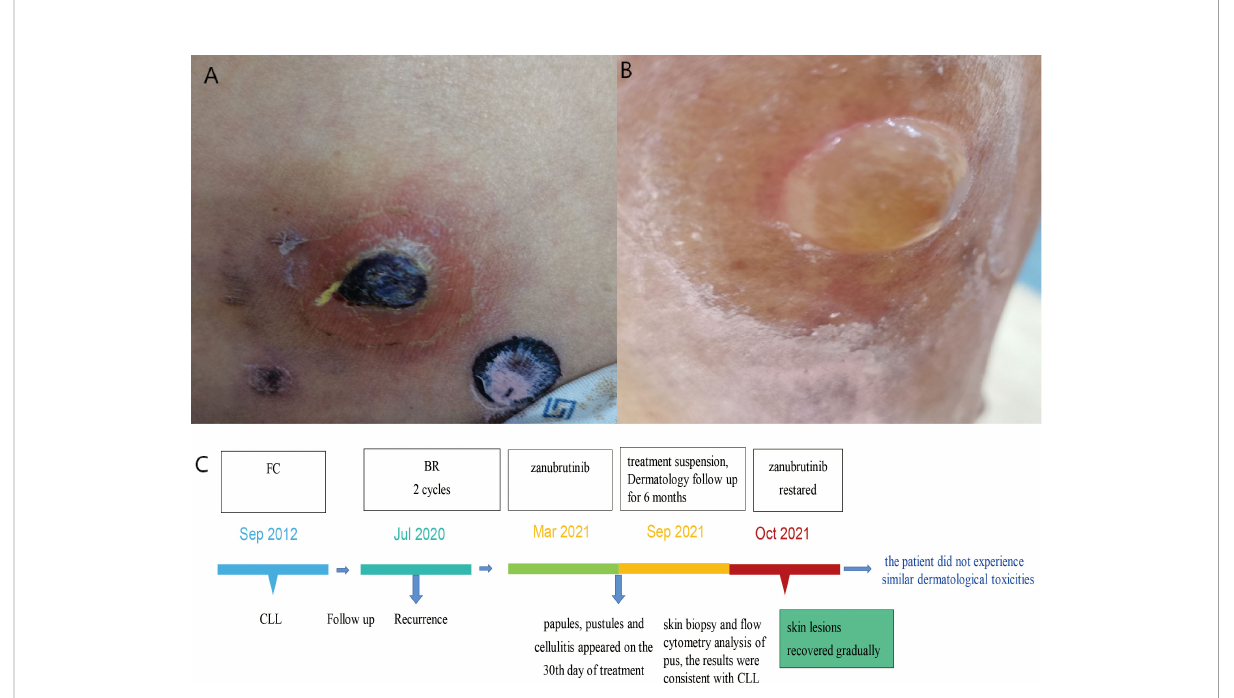
FIGURE 3 Case 3 : A 69-year-old man with CLL. (A) cutaneous ecchymosis with central necrosis. (B) pustules on the left lower extremity. (C) The time line of this